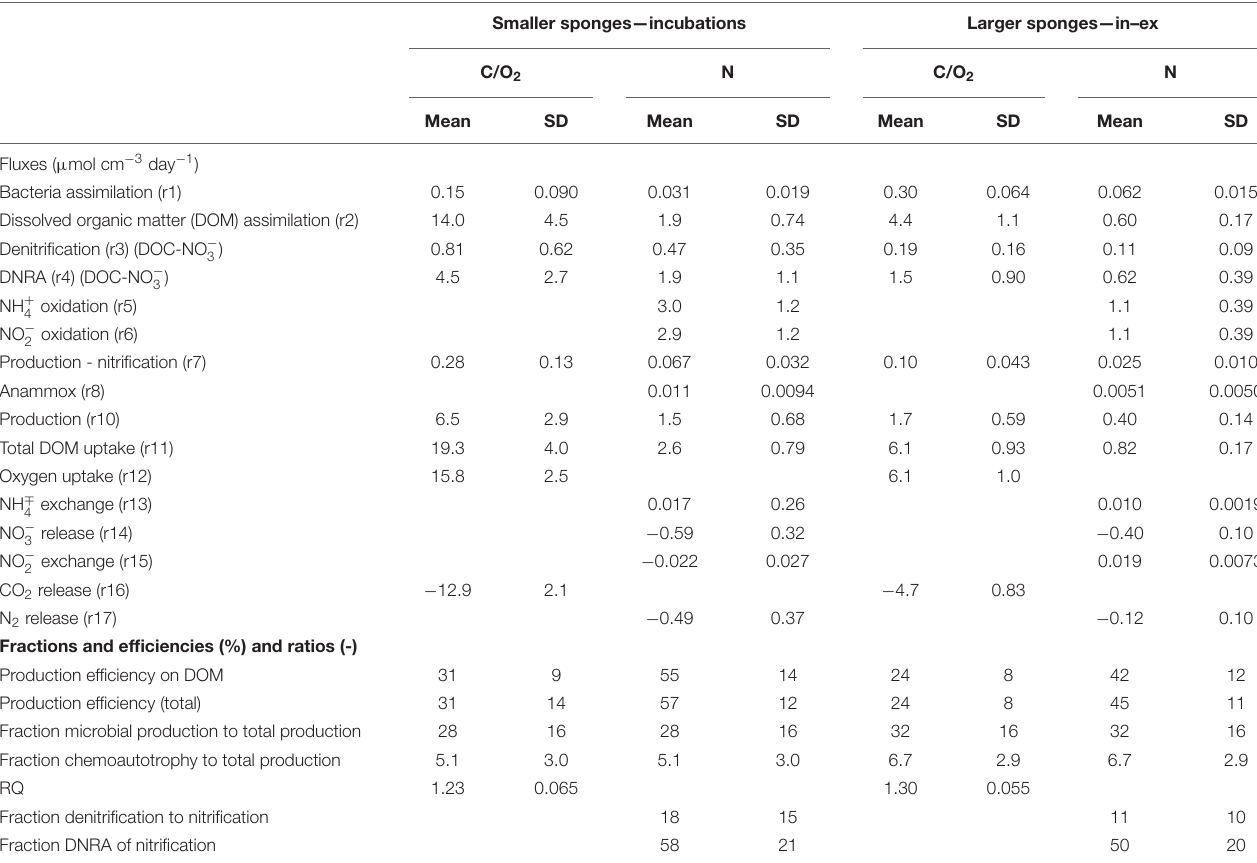
TABLE 3 | Metabolic network model results for smaller and larger Geodia barretti for C/O 2 and N. Smaller sponges—incubations Larger